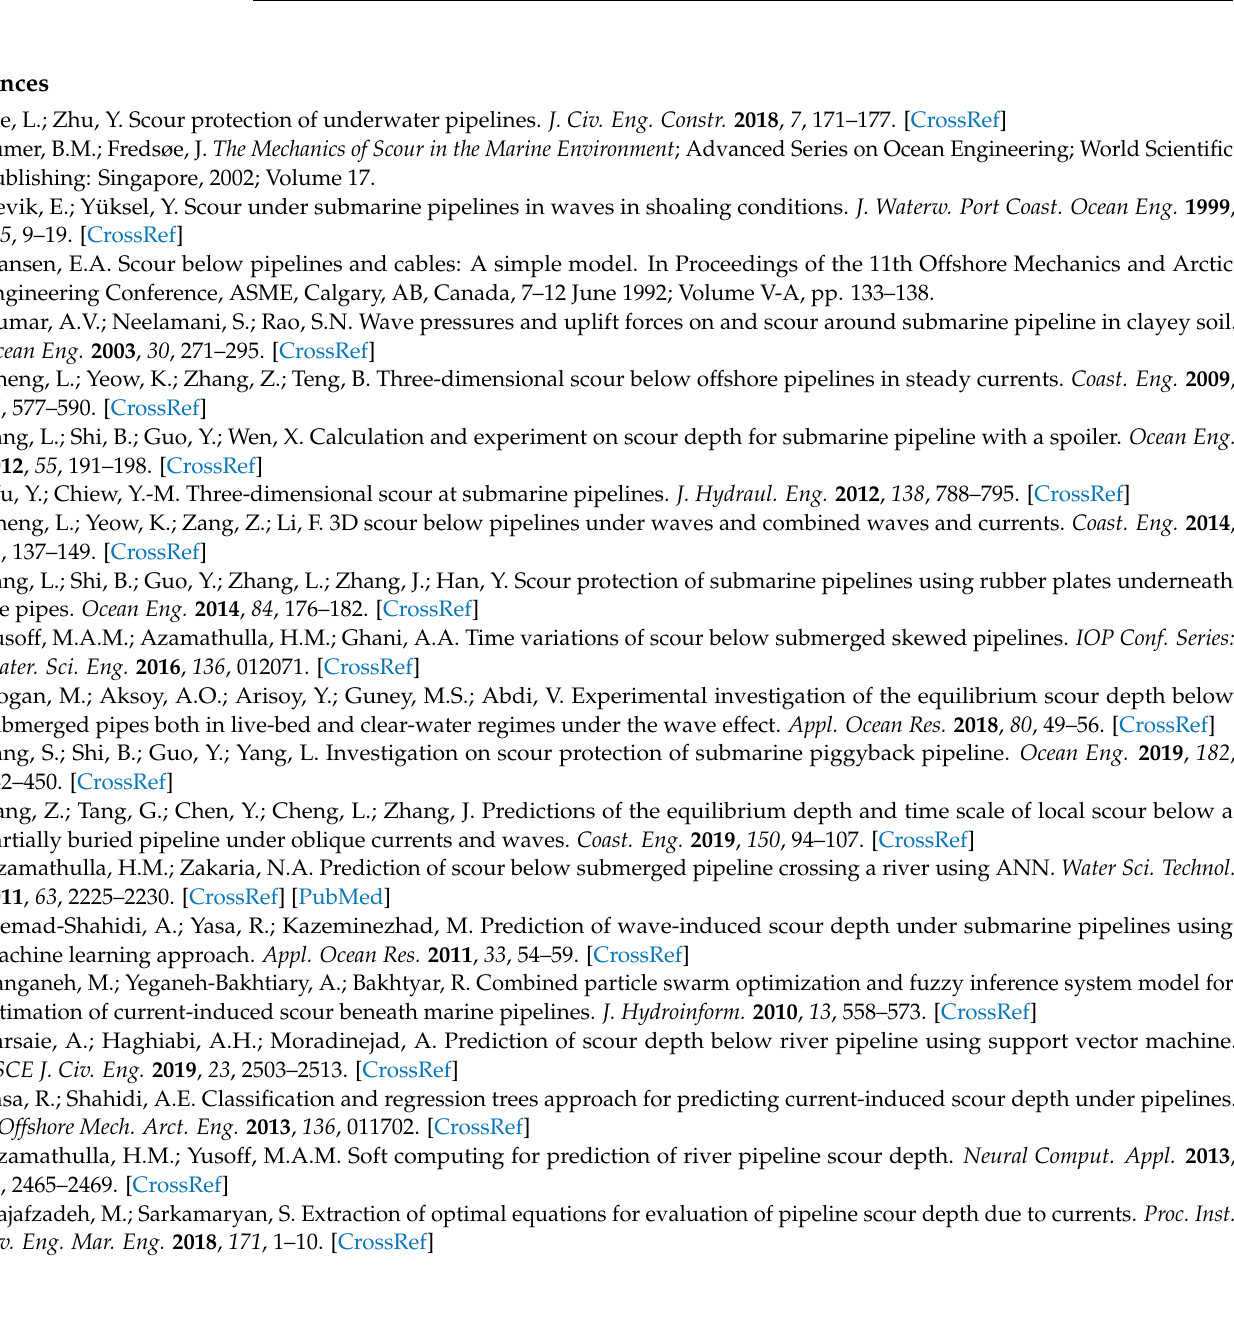
Table A9. Linear equations obtained by M5MT model to predict V ∗